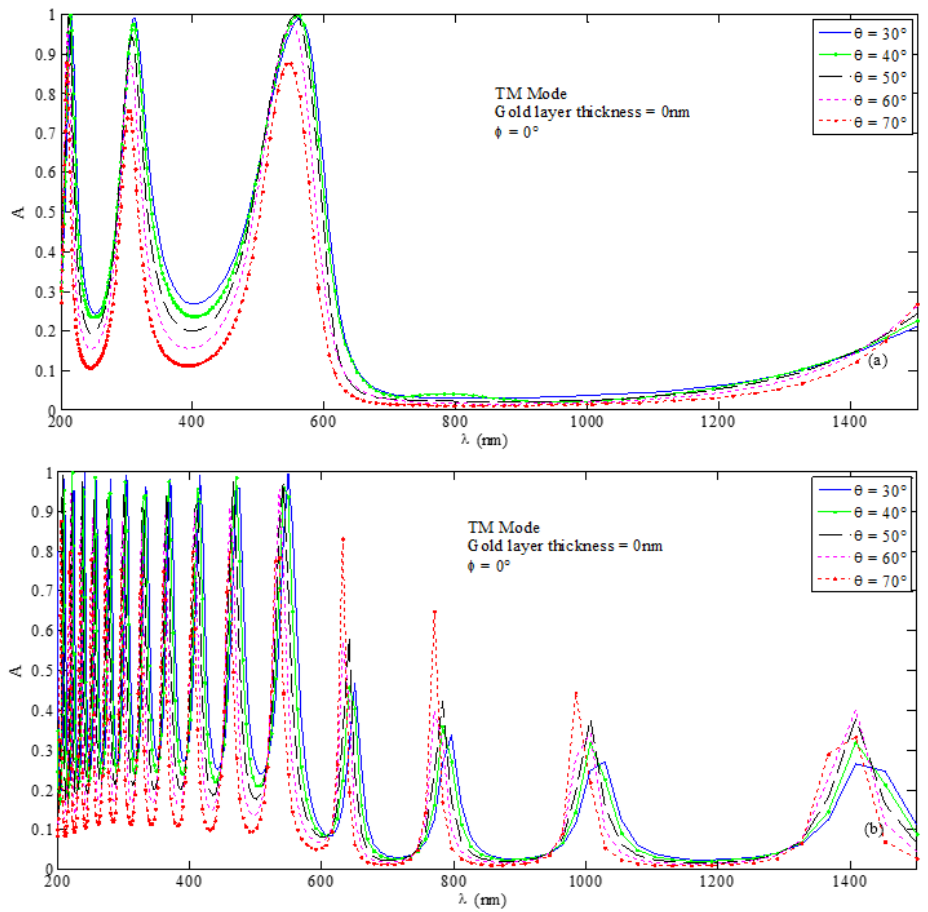
Figure 12. Absorption spectra obtained for 𝑑 = 0 under the TM wave excitation incidence and corresponding to ( a ) 𝑡 = 100 nm and ( b ) 𝑡 = 500 nm.